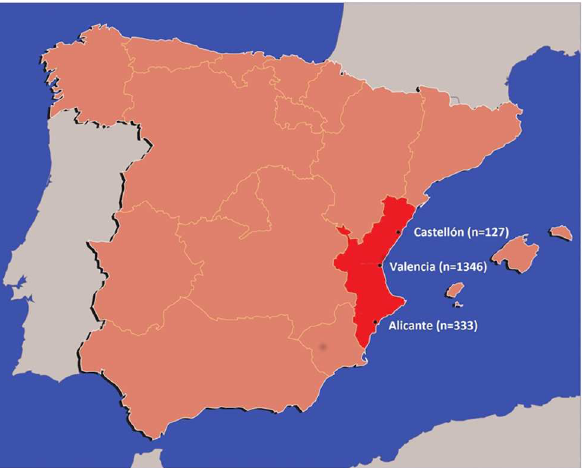
Fig 1. Location of the Comunidad Valenciana in Spain. The ComunidadValencianais highlightedin red. The locations of Valencia,Castello´n and Alicante, and the numberof HIV-1 sequencescollected in each of the three localities (from a total of 1806 sequences), are